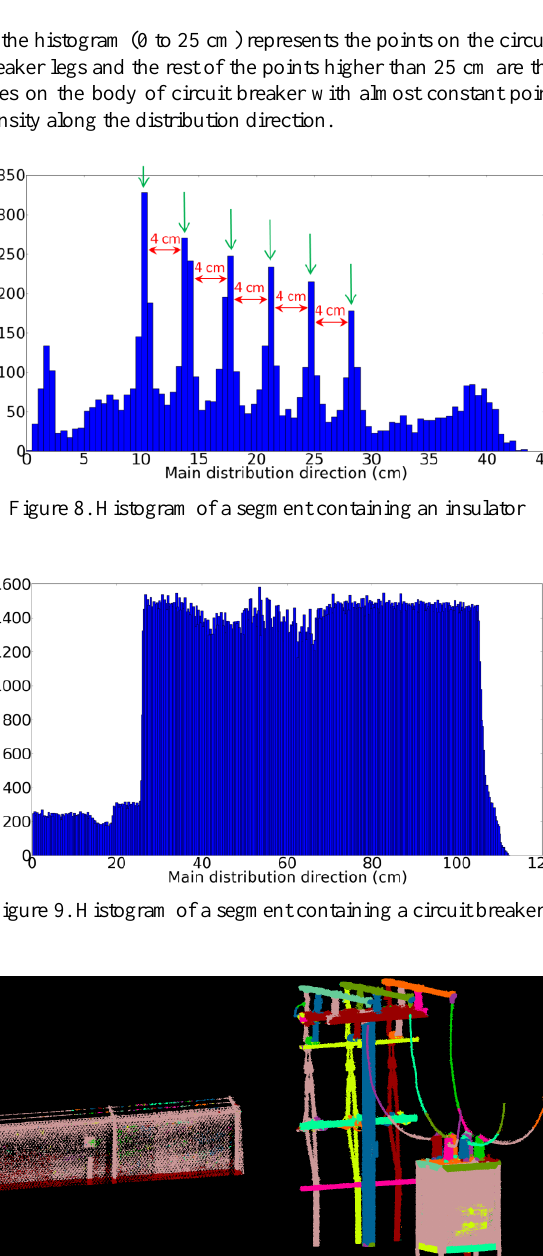
Figure 12. An occluded insulator which is not detected shown by a red arrow